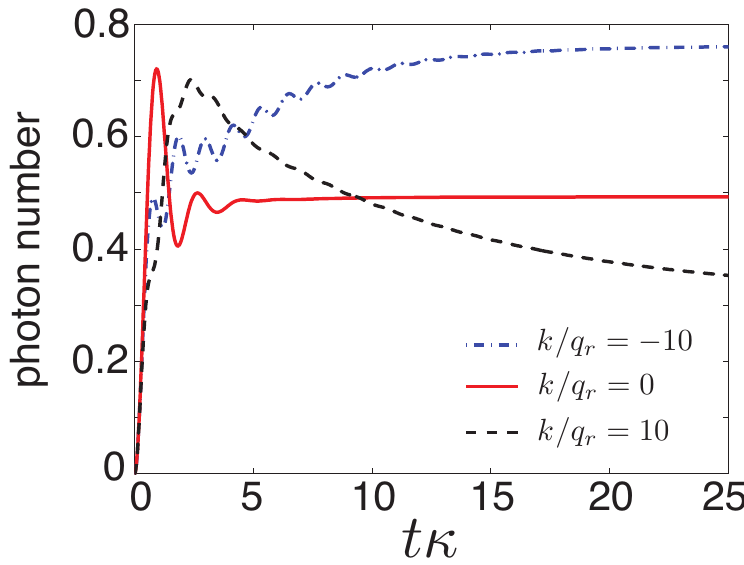
0; and | ↑(cid:105) = 10 , 0 , 10 . The steady-state r −